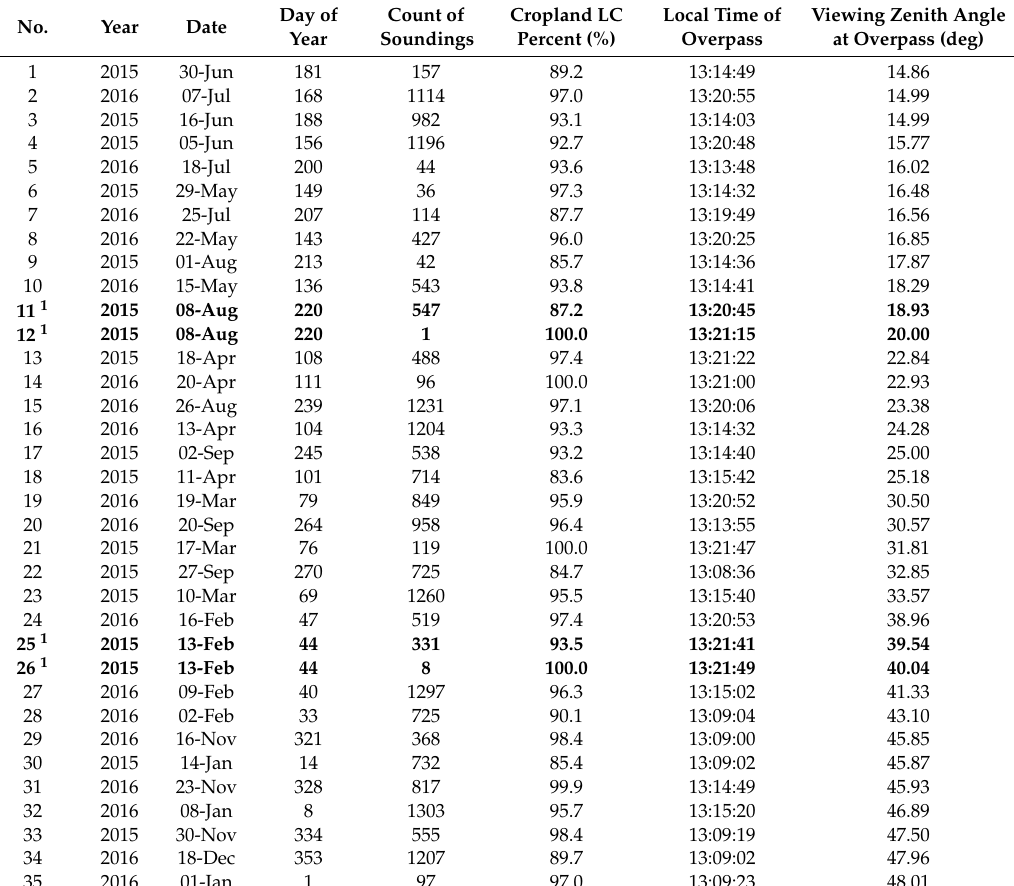
Table 1. Specific information of the 35 SIF (sun-induced chlorophyll fluorescence) measurements retrieved by OCO-2 (Orbiting Carbon Observatory-2) in Glint mode within a circular area of a 150 km radius from the Yucheng flux tower (from January 2015 to December 2016).